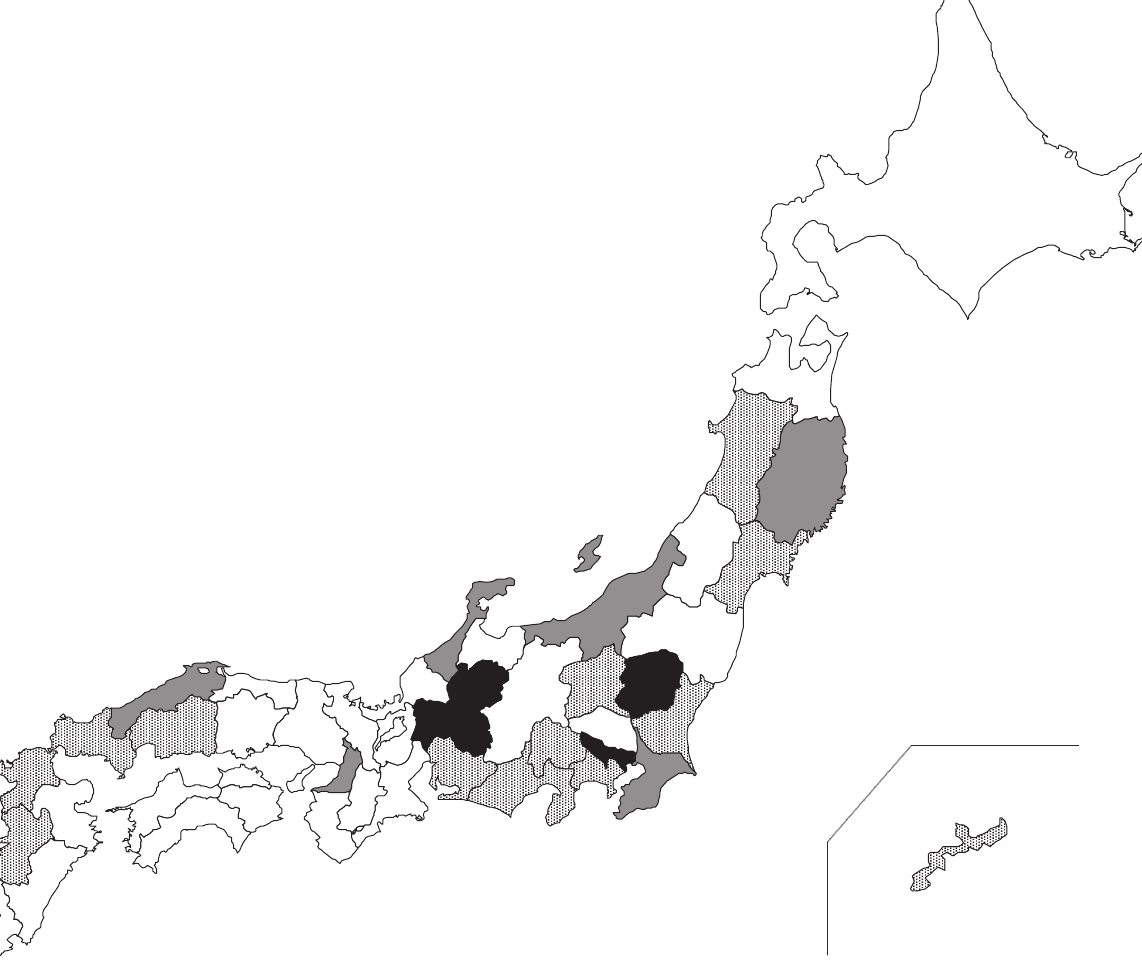
Figure 1. Sampling of the study participants: A map of Japanese prefectures. Dots represent 13 prefectures that participated in 1998 (Miyagi, Akita, Ibaraki, Gunma, Kanagawa, Yamanashi, Shizuoka, Aichi, Hiroshima, Yamaguchi, Fukuoka, Kumamoto, and Okinawa). Gray represents six prefectures that participated during the period 1998 – 2010 (Iwate, Chiba, Niigata, Ishikawa, Osaka, and Shimane). Black represents three prefectures that participated during the period 2010 – 2015 (Tochigi, Tokyo, and